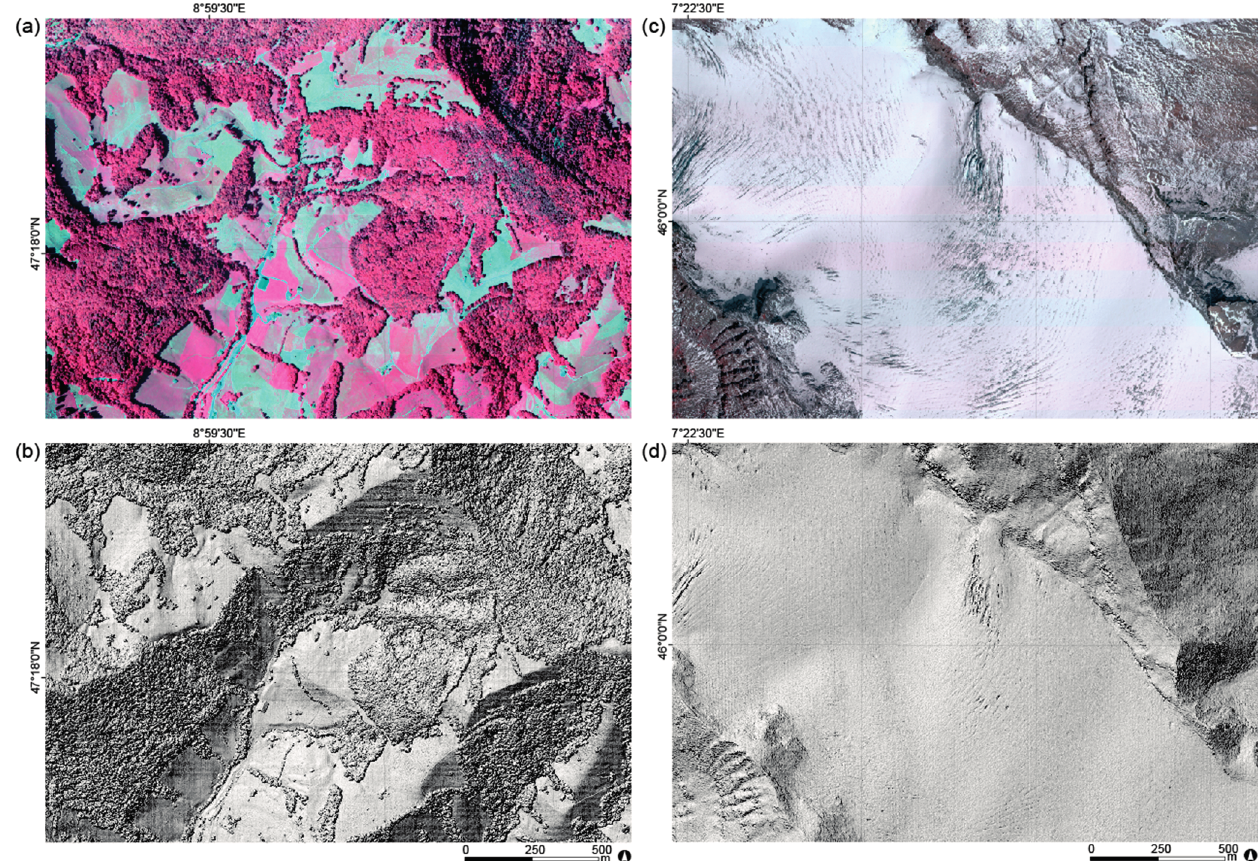
Figure 3. Examples of the performance of the two different correlation strategies: “ADS steep”, optimized for steep areas and very heterogeneous surfaces such as forest canopies ( a ) input CIR image and ( b ) shaded relief of the resulting DSM and “ADS flat”, optimized for homogeneous areas with little contrast such as glaciers ( c ) input CIR image and ( d ) shaded relief of the resulting